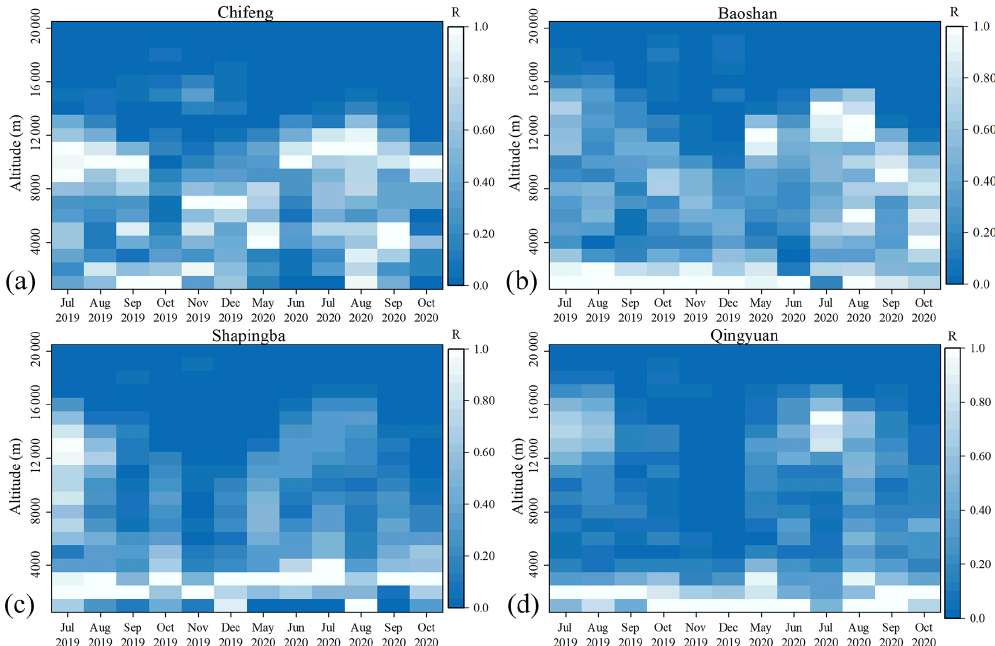
Figure 12. Vertical distribution of R values in different regions and months. (a) Chifeng, (b) Baoshan, (c) Shapingba, and (d) Qingyuan.